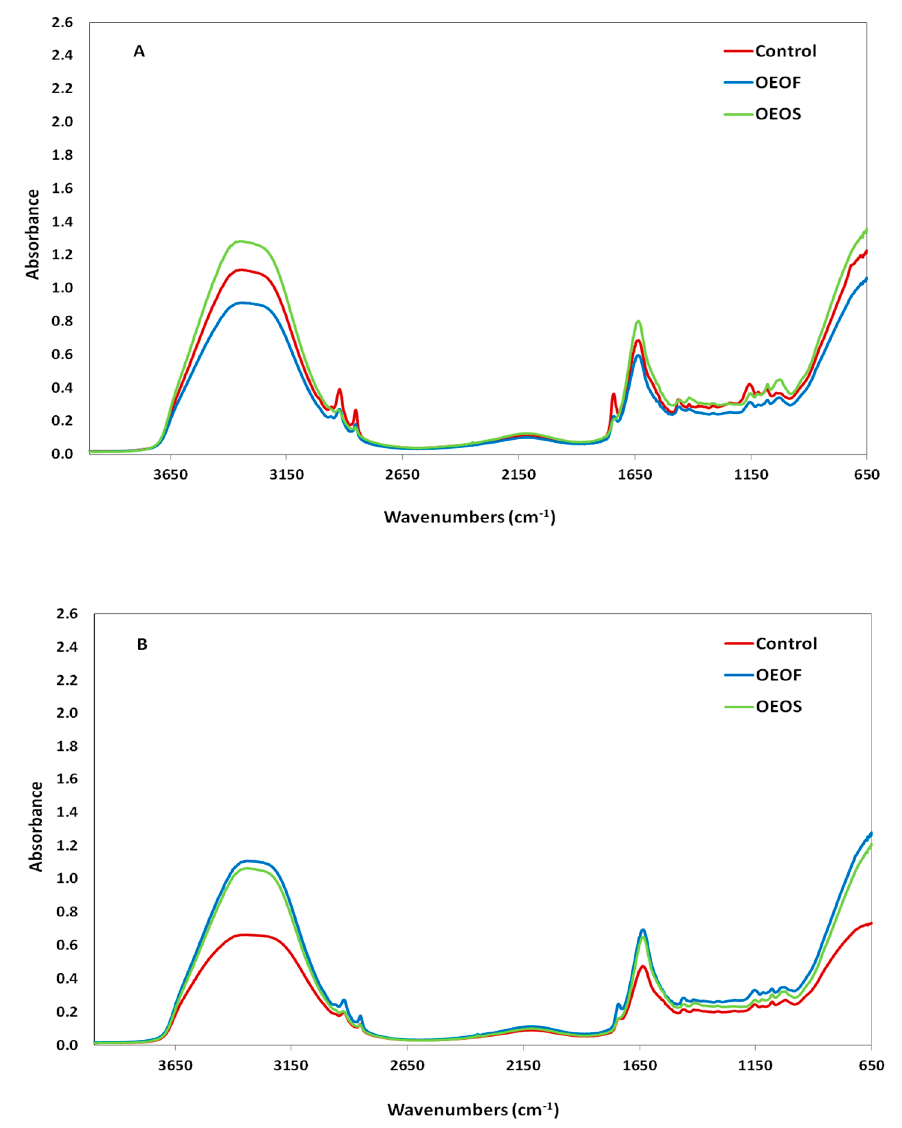
Figure 11. Typical raw FTIR spectra in the range of 4000–650 cm − 1 , at the end of the shelf-life at 12 °C, without ( A ) or after ( B ) high pressure processing treatment for control samples (–), samples with oregano essential oil-free edible films—OEOF (–), and samples with edible films supplemented with oregano essential oil—OEOS